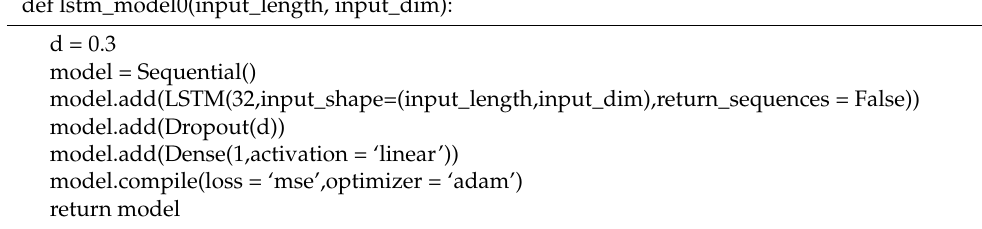
Table 2. Setting dropout within d = 0.3.